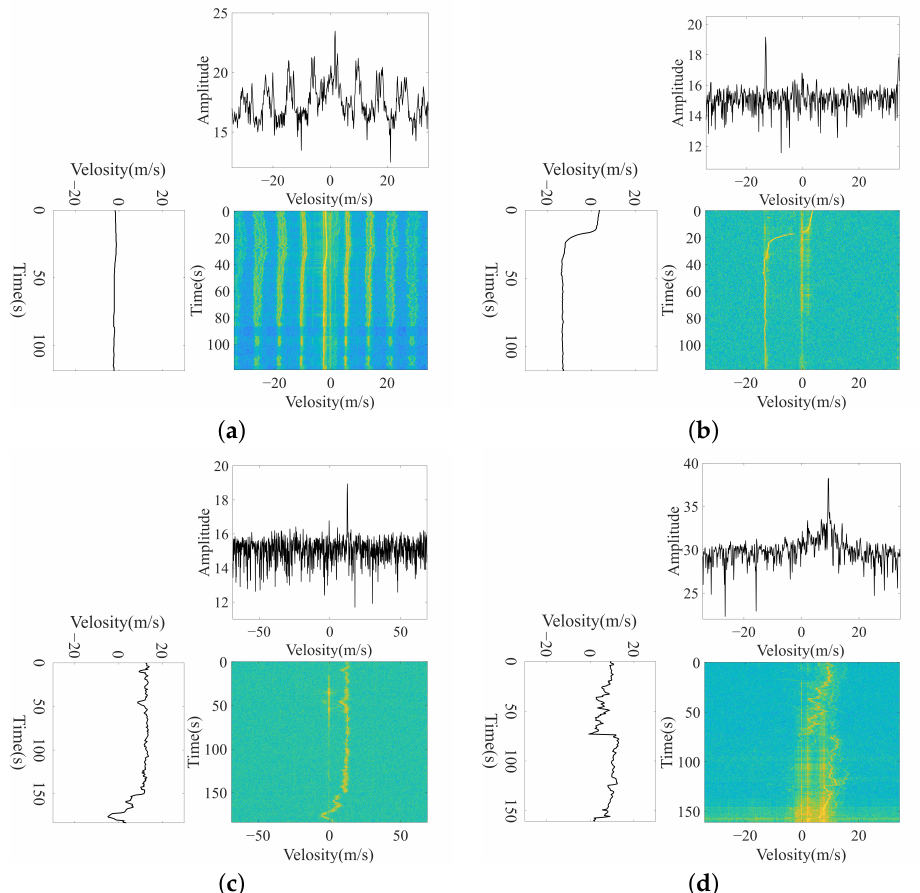
Figure 3. Movement and m-DS feature extraction of UAVs and birds from spectrogram. Spectrogram can be seen in the middle subfigure. A frame signal in the spectrogram is shown in the top subfigure for m-DS feature extraction. The subfigure on the left represents the change of the target movement speed over time, which can be used for movement feature extraction. ( a ) Inspire2 UAV. ( b ) MAVIC Air2 UAV. ( c ) a bird. ( d ) a group of